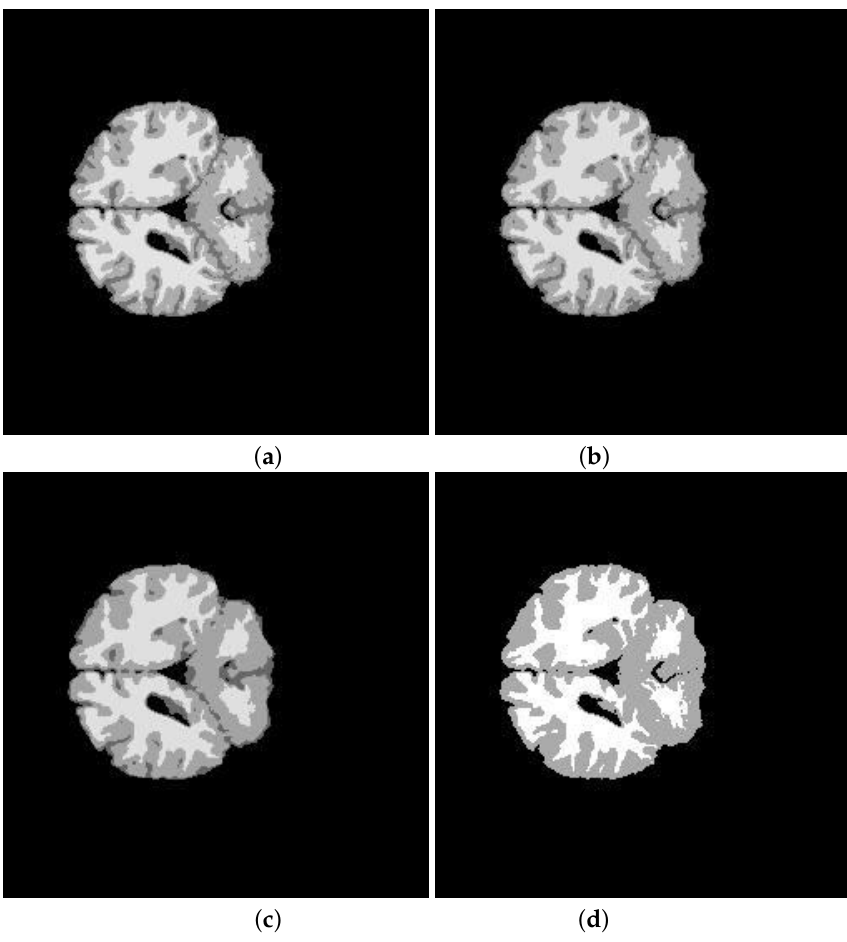
Figure 7. Best segmentation of Image 205-3 using K-means ( a ) FCM ( b ) SFCM ( c ) and KFCM ( d ). Table 3. Comparative results. JS, Jaccard Similarity; DSC, Dice Similarity